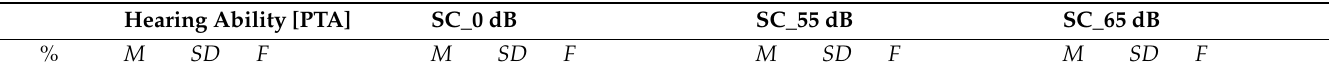
Table 1. Sample descriptors and univariate comparisons for general audiological (a), tinnitus-related (b), and other distress-related indices (c). PTA = pure tone audiometry; SC = speech comprehension; TRD = tinnitus-related distress; TQ = Tinnitus Questionnaire; THI = Tinnitus Handicap Inventory; TFI = Tinnitus Functional Index; PSQ = Perceived Stress Questionnaire; HADS_a = Hospital Anxiety and Depression Scale_anxiety subscale; HADS_d = depression subscale; ISR